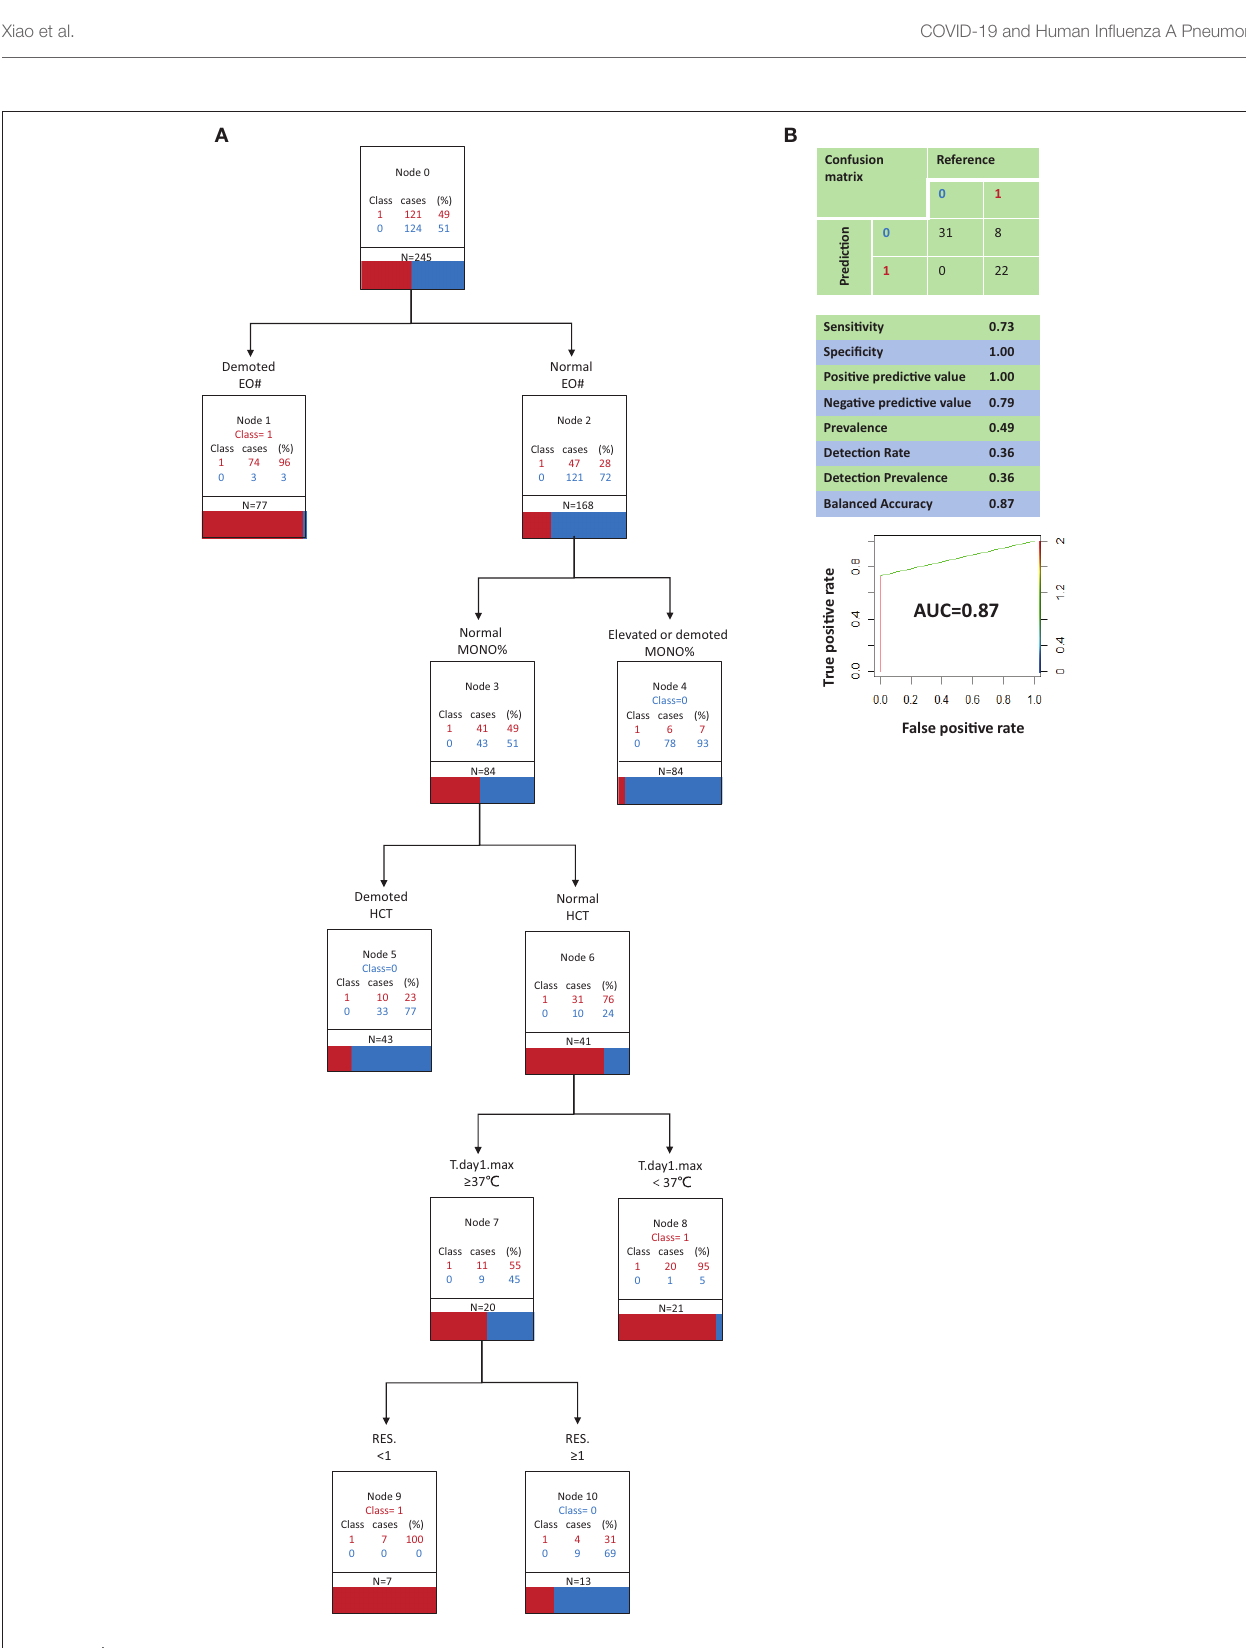
Frontiers in Medicine |